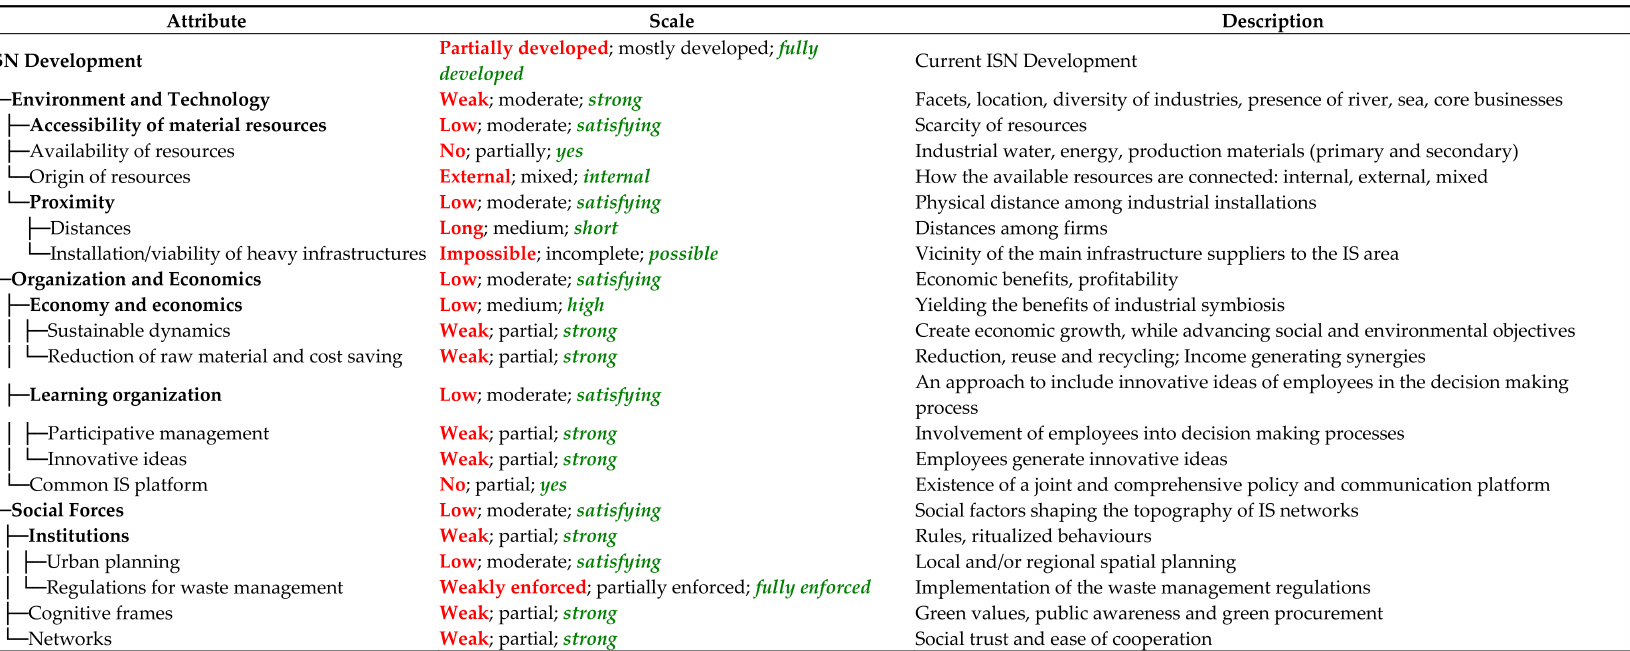
Table 1. DEX model tree, scale attributes and short description of